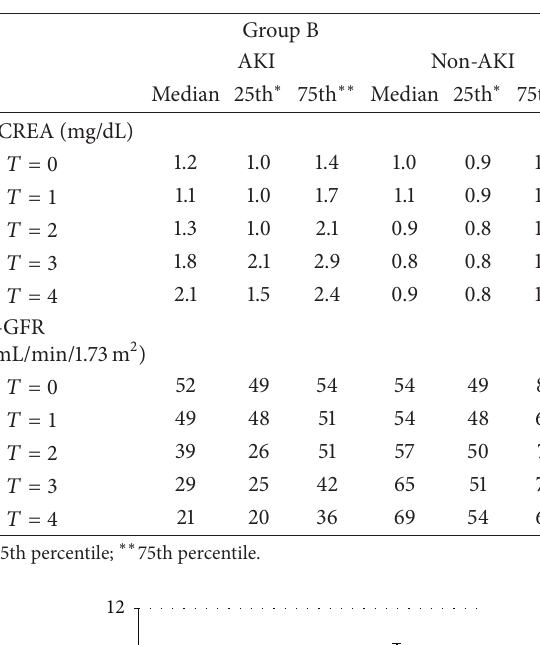
Table 3: Median, 25th, and 75th percentiles of plasma creatinine (pCrea) and e-GFR in Group B patients with and without AKI diagnosis.